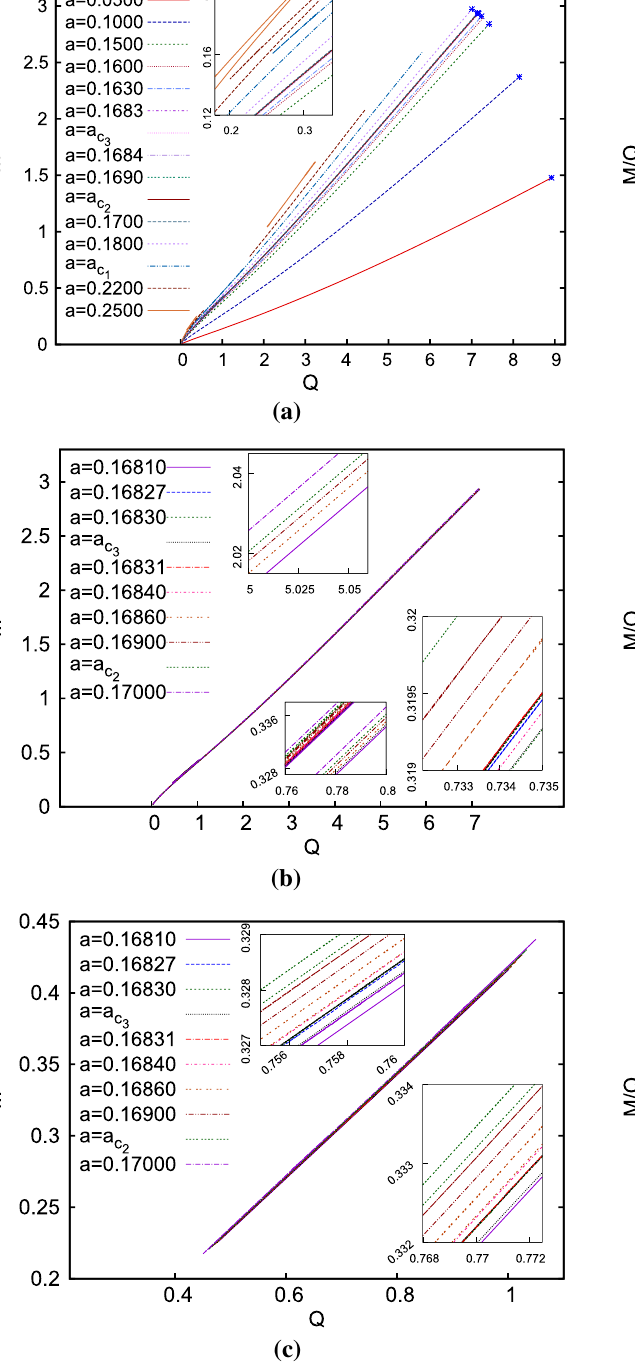
Fig. 8 a – c The mass per unit charge M / Q versus the charge Q for the same set of solutions. The asterisks represent the transition points from the boson stars to boson shells, and the inset magnifies a part of the diagram value of the mass and the charge. Whenever a new spike is encountered, a new unstable mode should arise, analogously to the case of non-compact boson